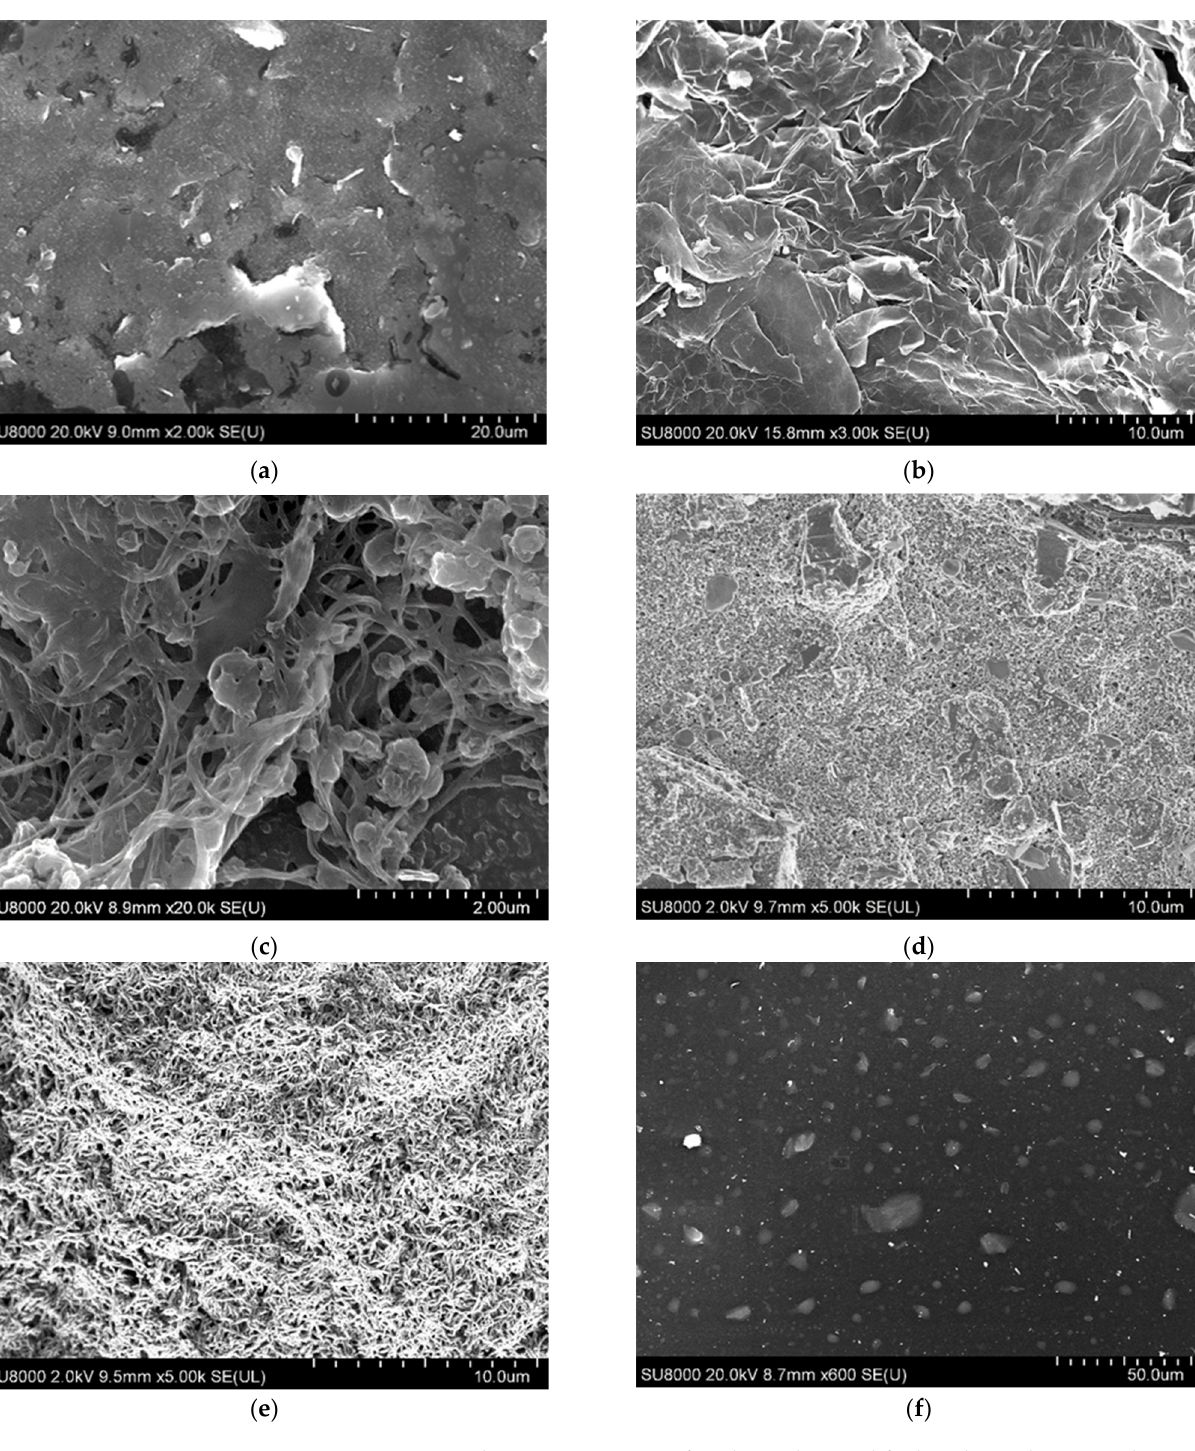
Figure 4. Scanning electron microscopy for electrodes modified with conductive polymers and nanocomposite materials: ( a ) clean printed electrode; ( b ) electrode modified with TEG; ( c ) electrode modified with CNTs; ( d ) electrode modified with pNR; ( e ) electrode modified with PANI; ( f ) electrode modified with CNTs, pNR, and covered with a bovine serum albumine (BSA) membrane. The used printed electrode has a highly developed surface (Figure 4a), which pro- vides a large area of contact between the enzyme and the conductive matrix and makes it